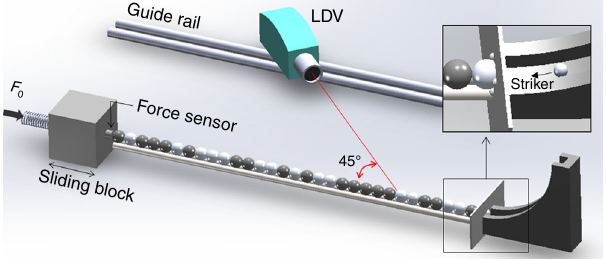
Fig. 1 Schematic of our experimental setup. The inset shows details of the boundary condition in front of a granular chain